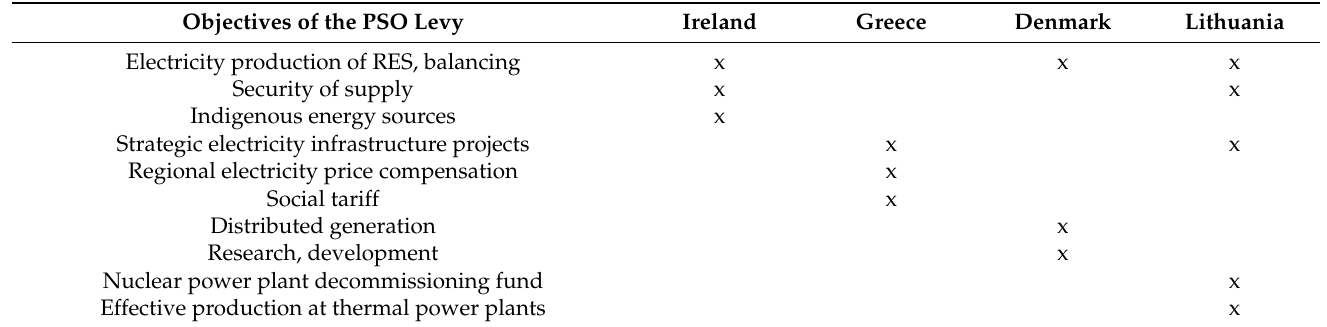
Table 1. Distribution of the collected PSO levy by country (designed by the